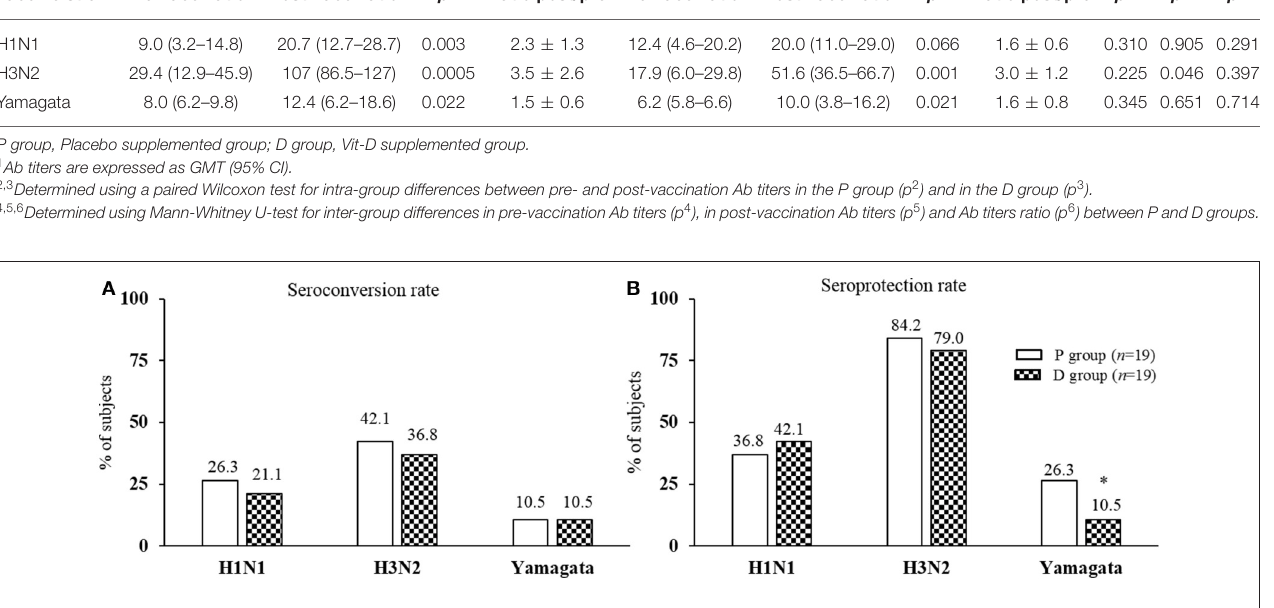
FIGURE 5 | Post-vaccination seroconversion and seroprotection rates. (A) Seroconversion rate: percentage of subjects achieving at least a 4-fold increase or an increase from > 10 to 40 in Ab titer for seronegative subjects; (B) Seroprotection rate: percentage of subjects reaching an Ab titer 40. *Significantly different between P and D group using Mann-Whitney U -test ( p <